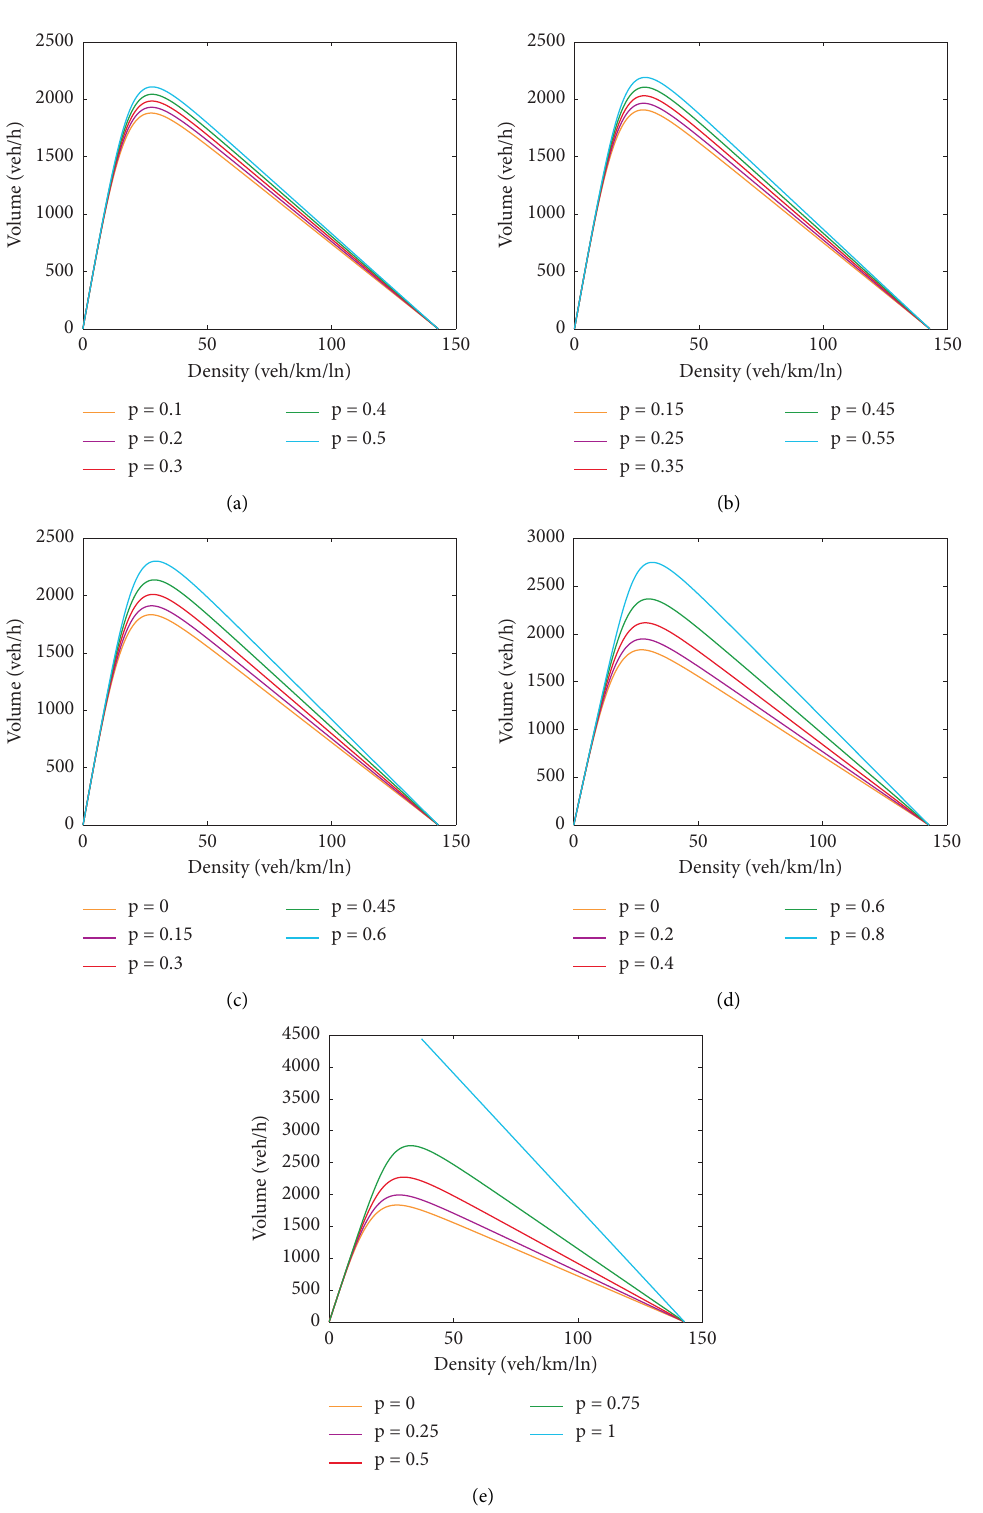
Figure 5: Fundamental diagrams under diferent platoon intensities: (a) E � 0, (b) E � 0 . 25, (c) E � 0 . 5, (d) E � 0 . 75, and (e) E �